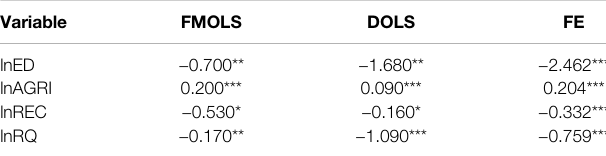
TABLE 5 | Panel estimation estimations.